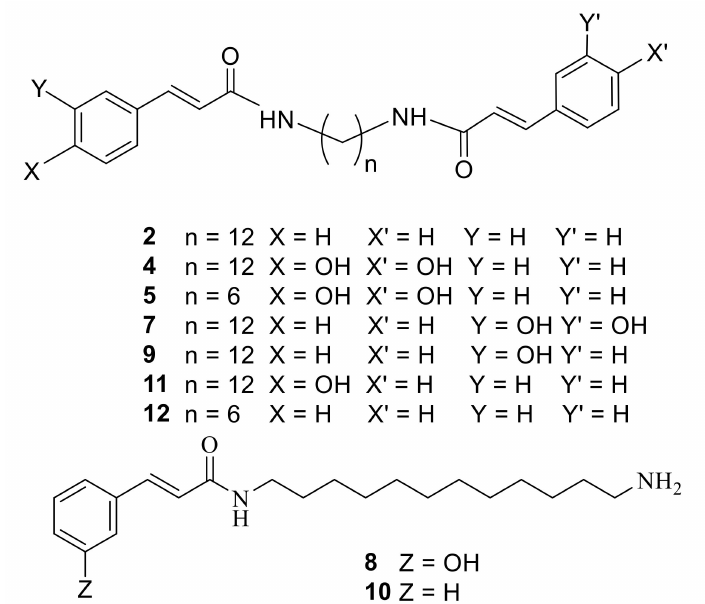
Figure 1. Chemical structures of cinnamamide